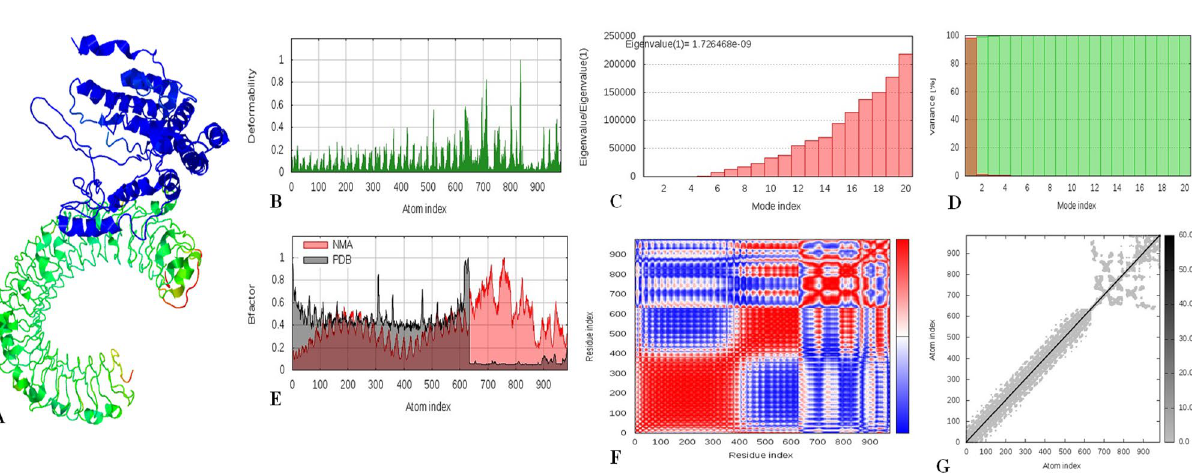
Figure 6. The results of molecular dynamics simulation of vaccine construct and TLR-3 docked complex. ( A ) NMA mobility, ( B ) deformability, ( C ) eigenvalues, ( D ) variance (red color indicates individual variances and green color indicates cumulative variances), ( E ) Bfactor, ( F ) co-variance map (correlated (red), uncorrelated (white) or anti-correlated (blue) motions) and ( G ) elastic network (darker gray regions indicate stiffer